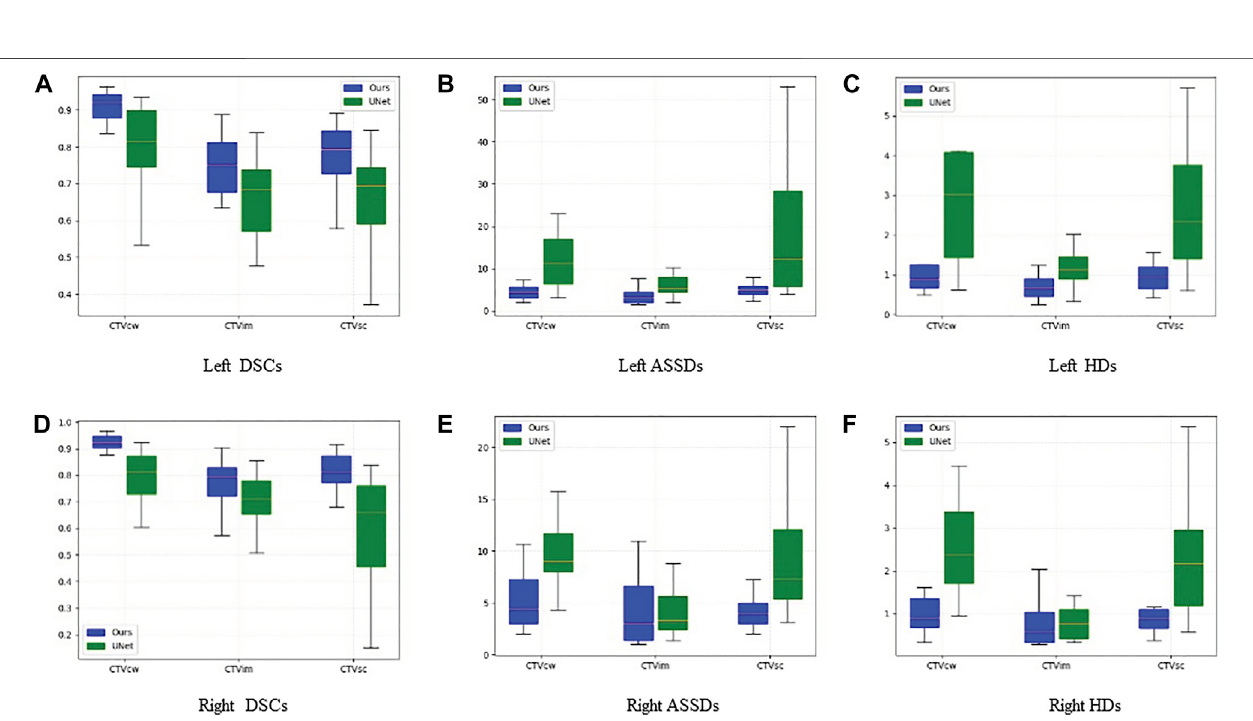
FIGURE3| Box-plotsofDSC,HDandASSDinleftCTVsandrightCTVsonthetestsetusingthegoldstandardasreference.Bluemeansourmethodresult.Green means U-Net's result. By comparison, we can see that the effect of blue is much better than that of green. Details are given below.